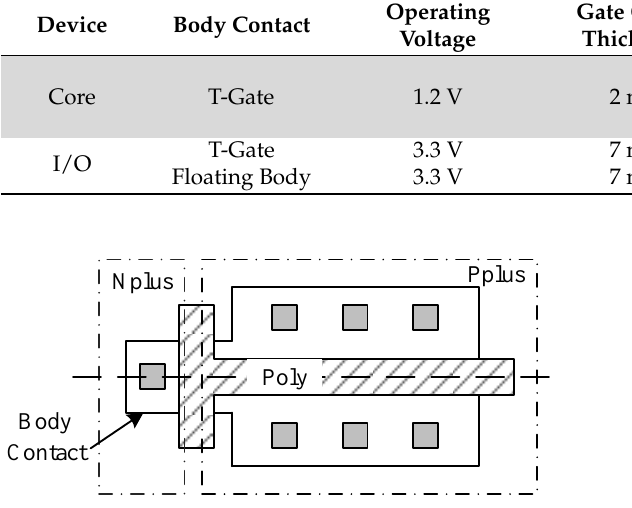
Figure 2. Layout of PMOS transistor used in our study.